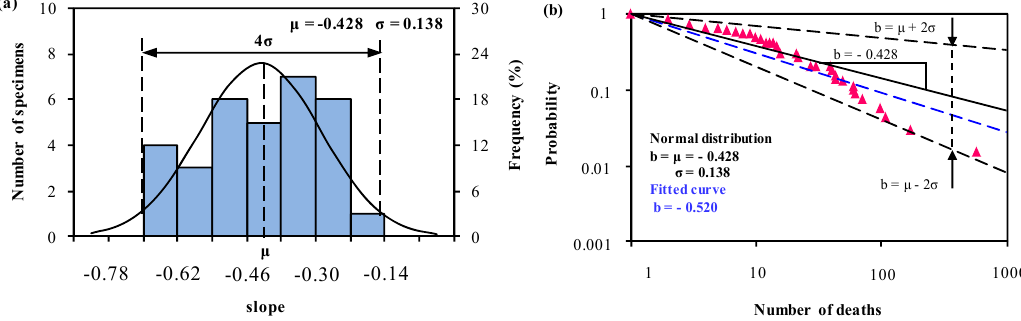
Figure 5. ( a ) Normal distribution analysis of the slope b i , and ( b ) predictions from Equation (1) and Equation (3) based on the normal distribution analysis of b i in ( a ) for Group 3 together with the statistical data (1931–2004) available in Oggero et al. [11].